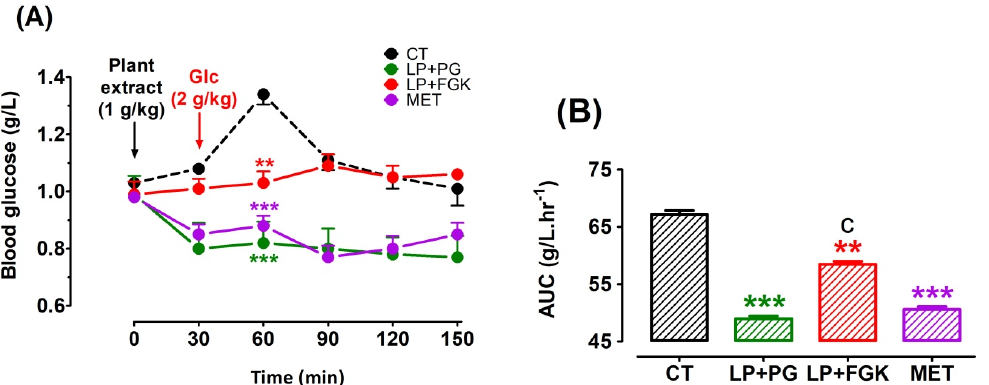
Figure 2. Acute and chronic OGTT after oral treatment of rats with plant extracts. Rats were force-fed intragastrically with distilled water as a negative control (CT, ■ ), 1 g/kg of the different aqueous plants extracts (LP, ■ ; PG, ■ ; FGK, ■ ; GO, ■ ), or 1 g/kg of the reference antidiabetic drug metformin (MET, ■ ) for 4 weeks. OGTT was performed on fasted rats every 30 min during 2 h after the first glucose (2 g/kg) overload (acute, panel ( A )) and at the end of the 4-week treatment (chronic, panel ( C )). Panels ( B ) and ( D ) show the AUCs (CT, ■ ; LP, ■ ; PG, ■ ; FGK, ■ ; GO, ■ ; MET, ■ ) for panels ( A ) and ( C ) respectively and were calculated using GraphPad Prism Version 8.0 software. * p < 0.05; ** p < 0.01; *** p < 0.001 in com- parison with the control (Dunnett’s test). ( a ) p < 0.05; ( b ) p < 0.01; ( c ) p < 0.001 in comparison with MET (Newman-Keuls test).